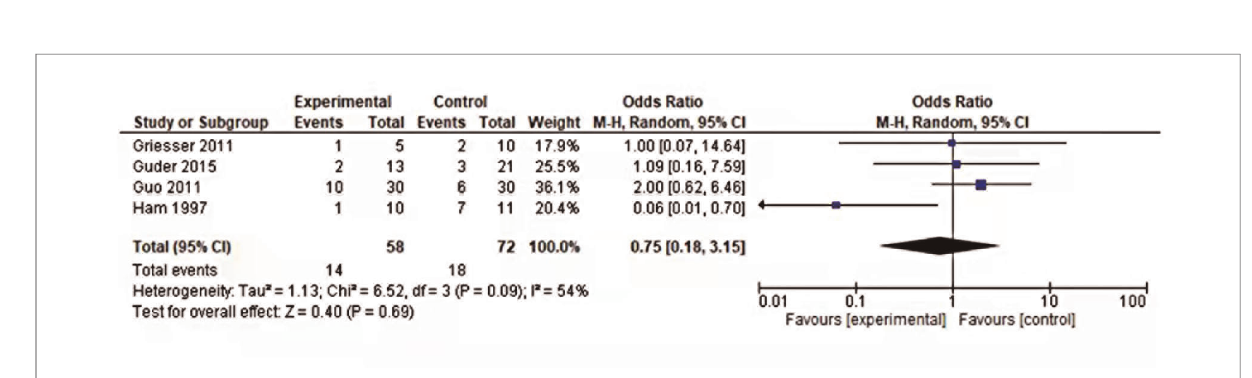
FIGURE 3 Forest plot of comparison metastasis of internal vs. external hemipelvectomy in pelvic